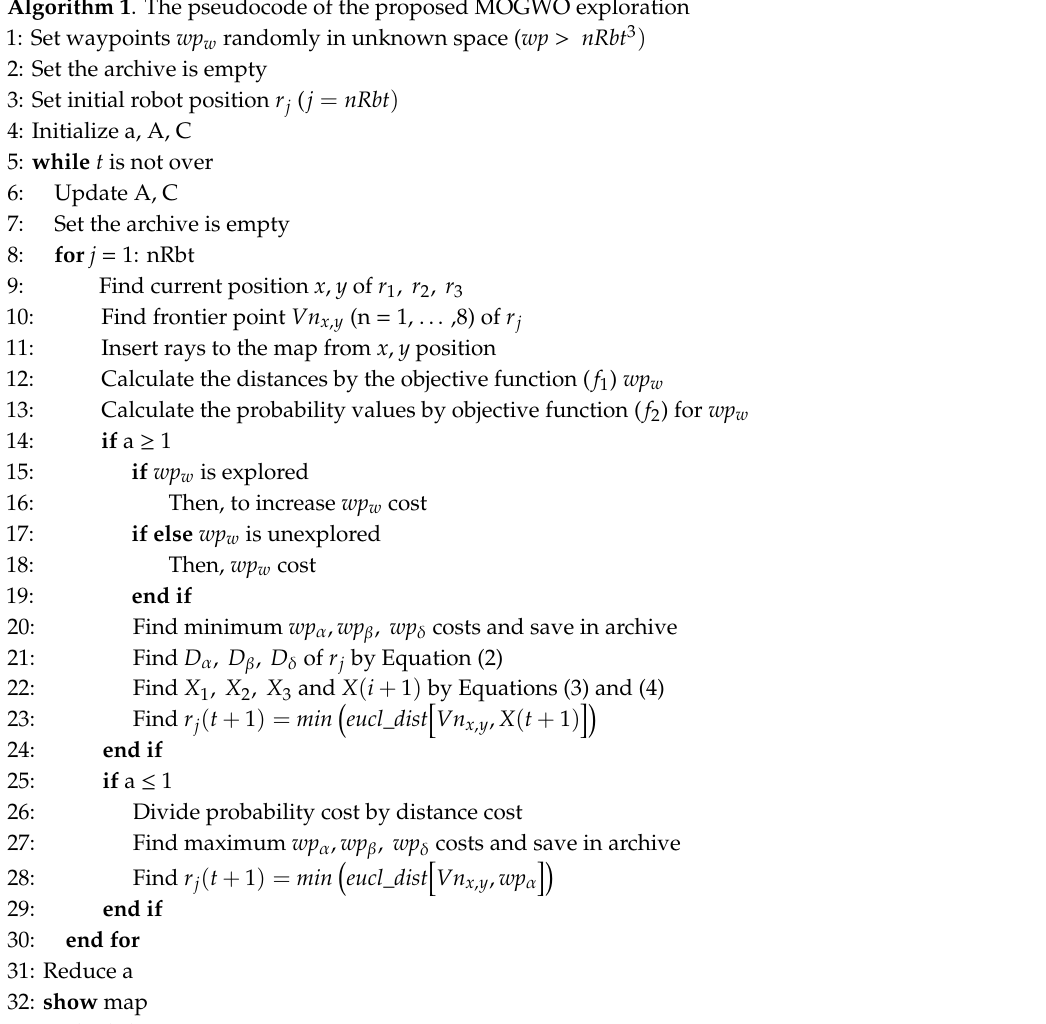
Algorithm 1 . The pseudocode of the proposed MOGWO